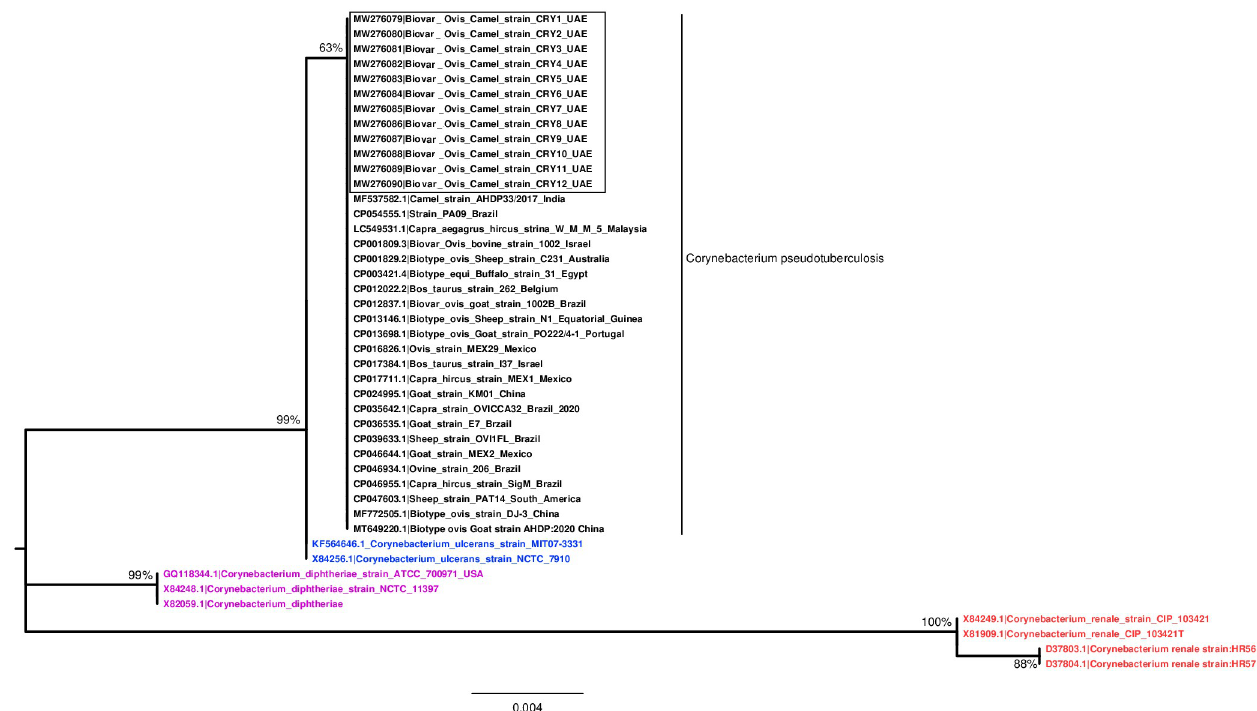
Fig 5. Phylogenetic tree by Maximum Likelihood method. The tree based on the sequence of 16S rRNA gene was constructed by MEGAX software [38] using Maximum Likelihood method based on the Kimura 2-parameter model [39]. We used a Boostrap value of 1000 repetition, Corynebacterium pseudotuberculosis isolates (Black Square bordered) were included in this study as well as GenBank reference samples of the subspecies ovis and equi, a reference sequence of the Corynebacterium ulcerans (Blue), Corynebacterium renale (Red) and Corynebacterium diphtheria (Pink).